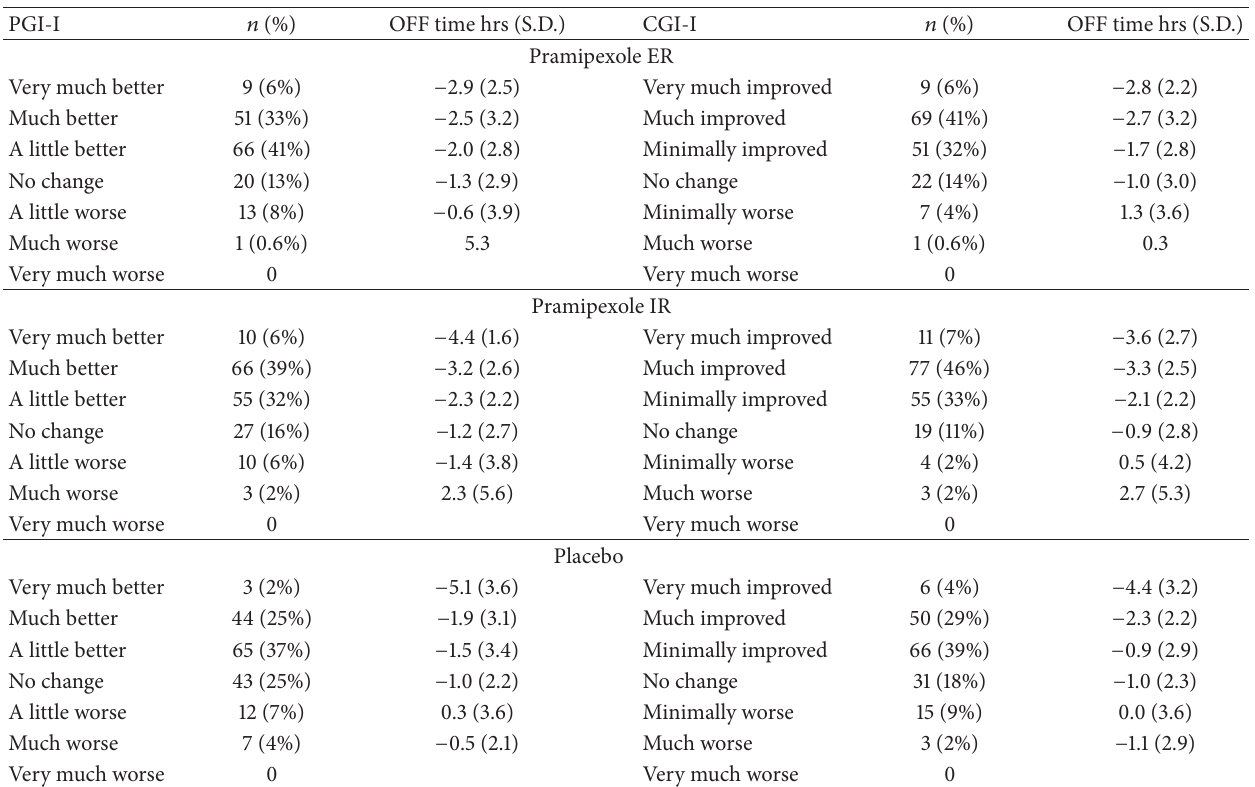
Table 3: Mean changes in OFF time according to PGI-I and CGI-I ratings by treatment group in the advanced PD study. PGI-I 𝑛 (%) OFF time hrs (S.D.) CGI-I 𝑛 (%) OFF time hrs (S.D.) Pramipexole ER Very much better Much better